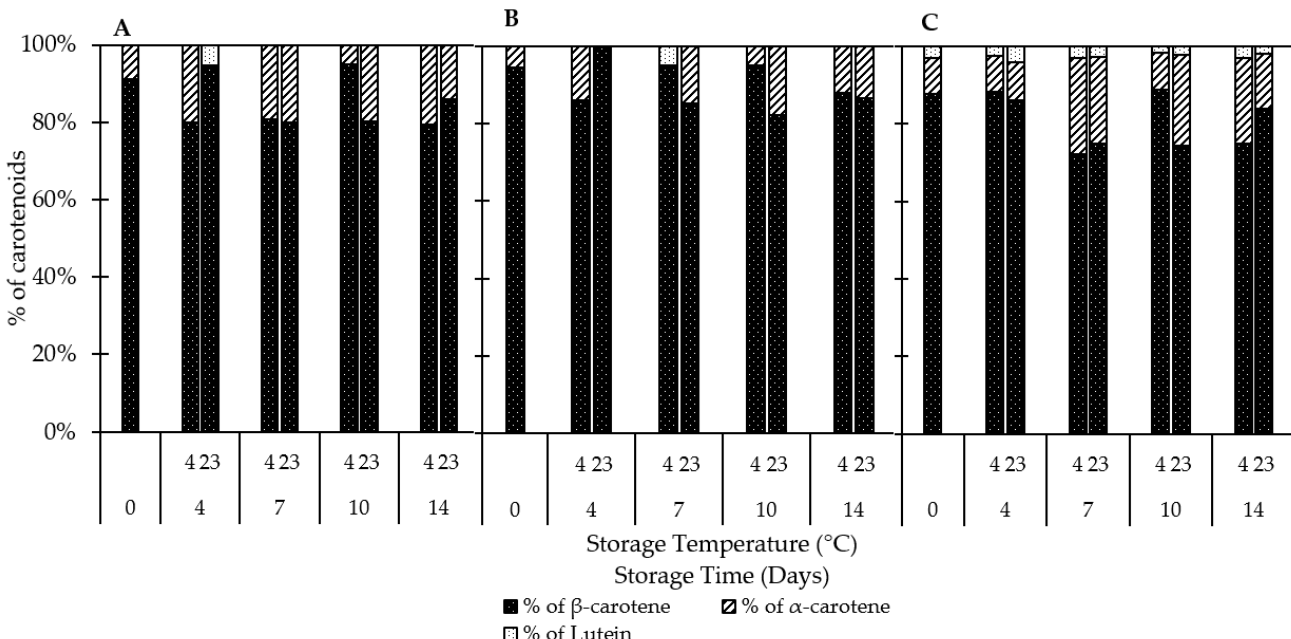
Figure 4. Individual carotenoids in ( A ) outer flesh; ( B ) inner flesh; ( C ) peel. Data are presented as mean (SE not shown; n = 3).